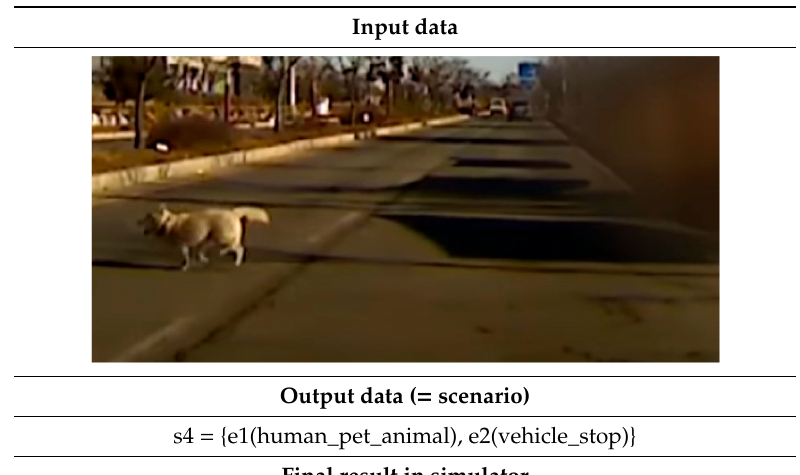
Table 9. Scenario Generation Result